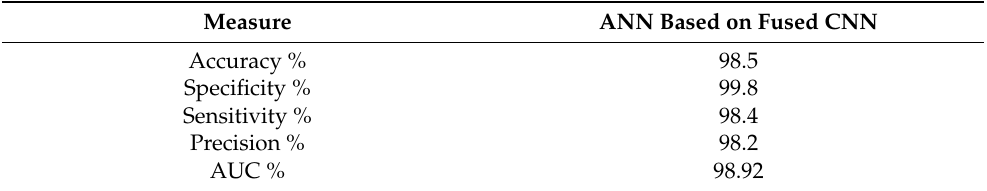
Table 4. Performance of the ANN according to fused features between the VGG ‐ 16 and GoogLeNet models.